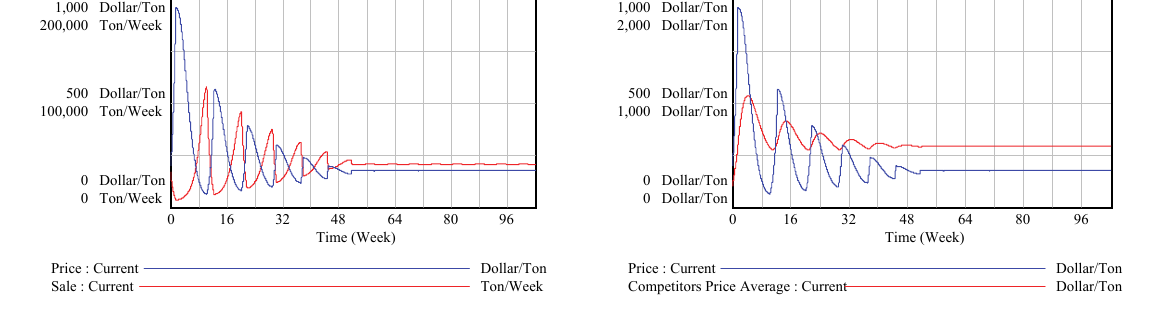
Fig. 7. The results of the change on price on other players’ production and price